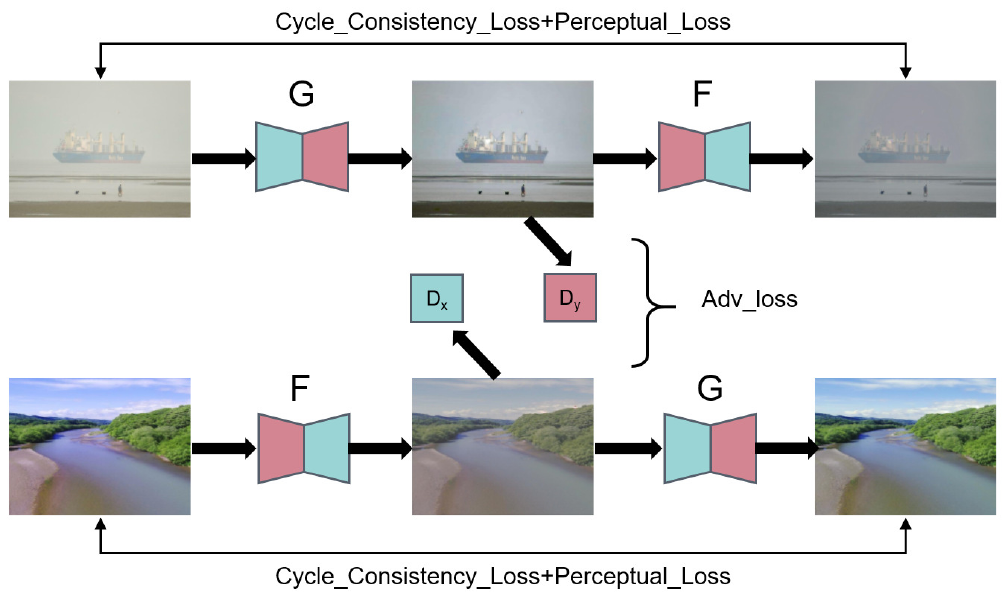
Figure 2. The main architecture of the proposed OverWater Image (OWI)-Dehazing network. G and